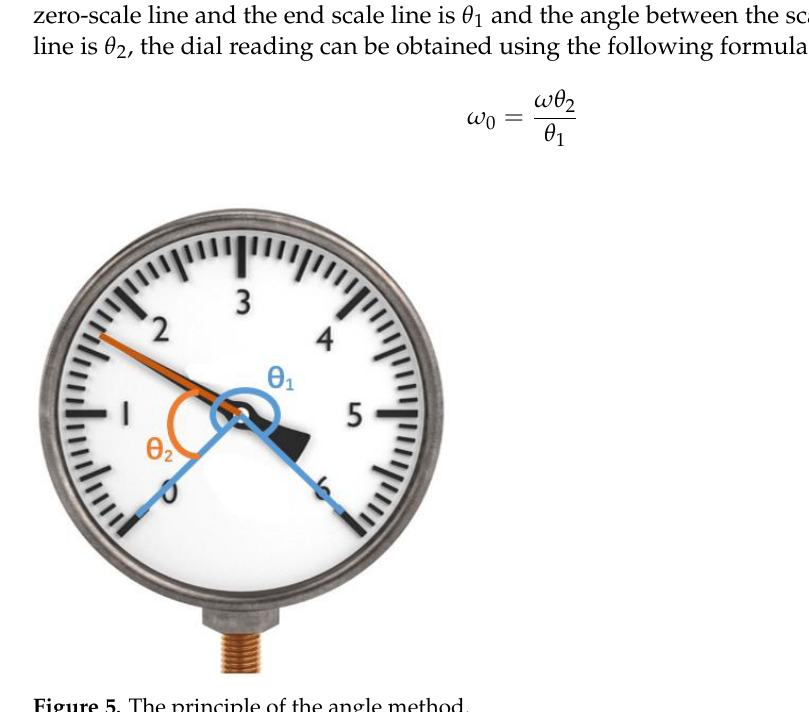
Figure 5. The principle of the angle method.